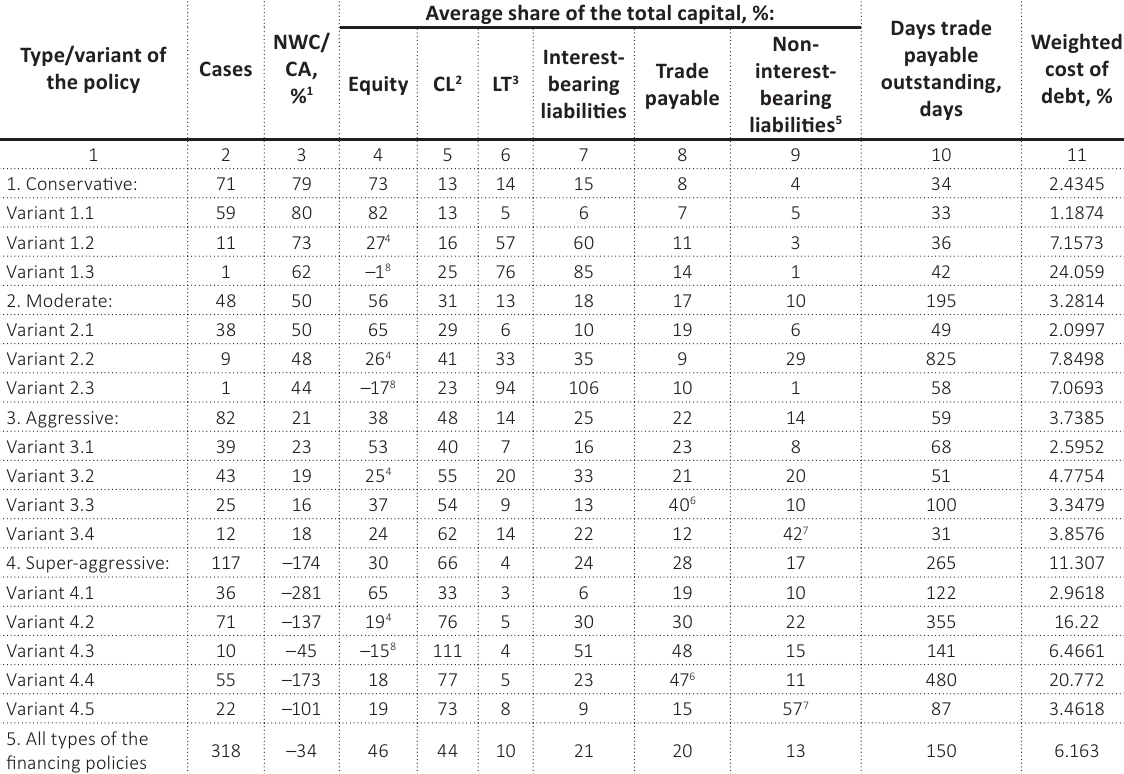
Table 1. Variants of the financing policy implementation